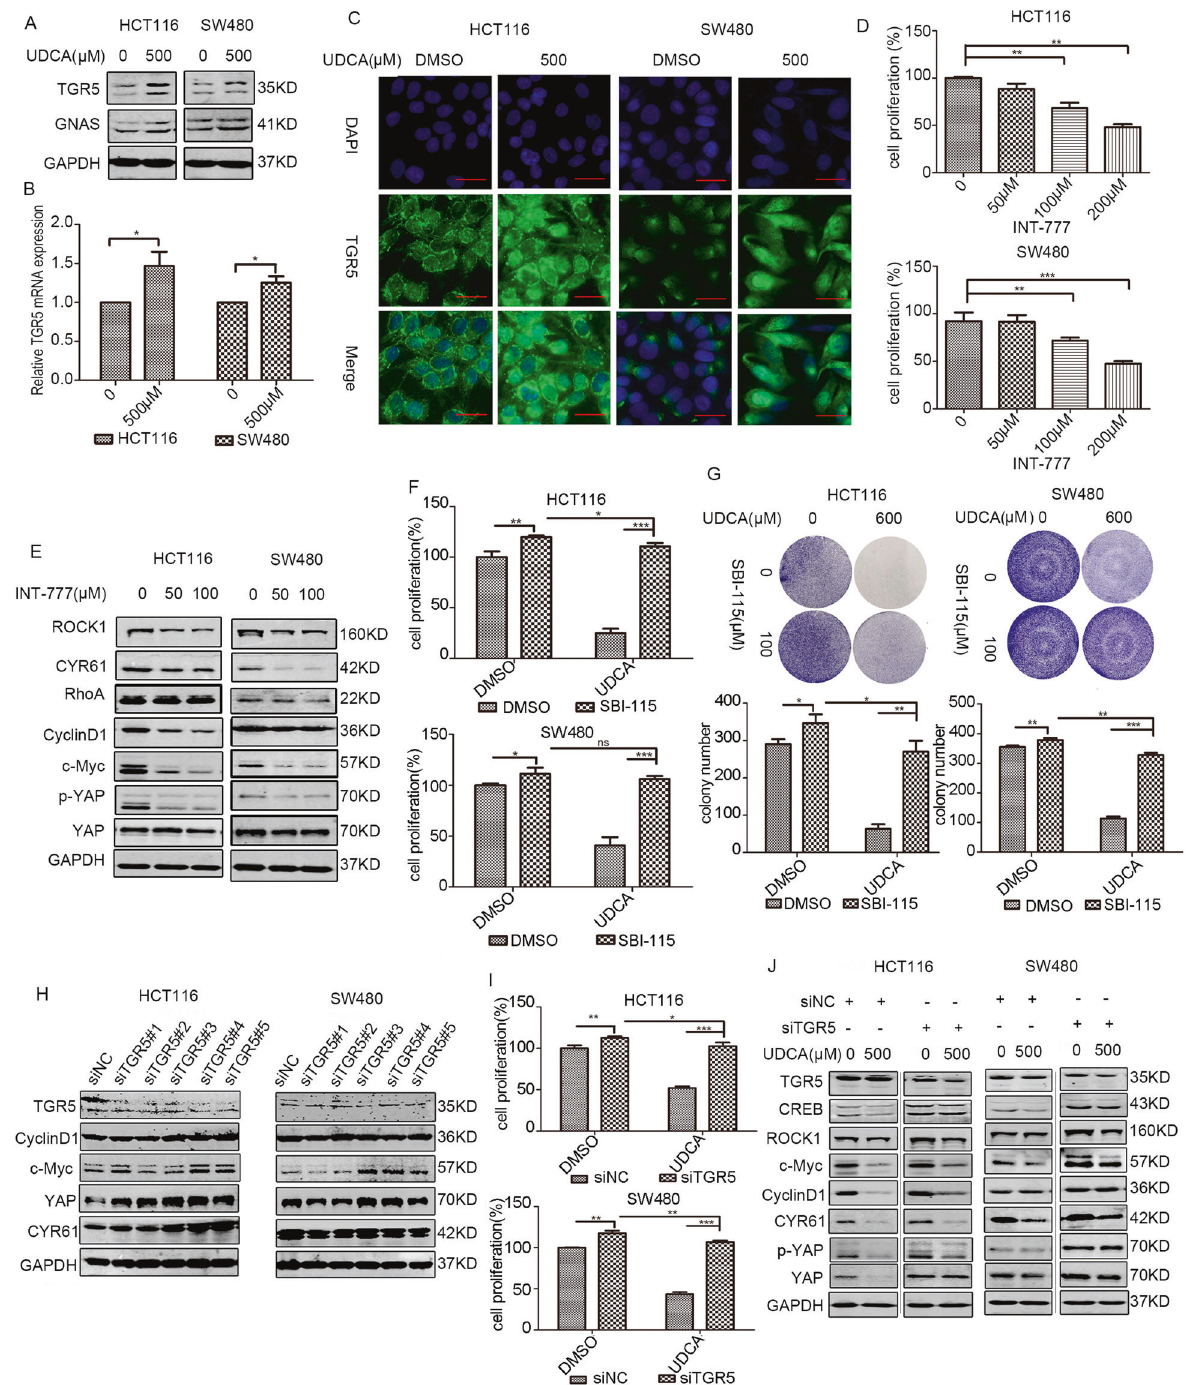
tissue, and decreased TGR5 expression correlates with a poor prognosis after considering the overall survival status (Fig. S4B – C). The results obtained in this study indicated that UDCA treatment increased TGR5 at both mRNA and protein levels in HCT116 and SW480 cells (Fig. 5A, B). Many studies demonstrated that after stimulating with agonist, GPCR on the cell membrane internalized, and was ubiquitinated and degraded in lysosome [44]. The beta2-adrenoceptor ( β 2-AR) is a canonical GPCR, the canonical GPCR beta2-adrenoceptor ( β 2-AR) is internalized, ubiquitinated, and fi nally degraded after